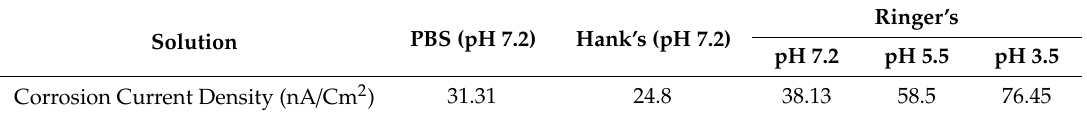
Table 1. Corrosion current densities in different simulated body fluids for Ti-6Al-4V [46].